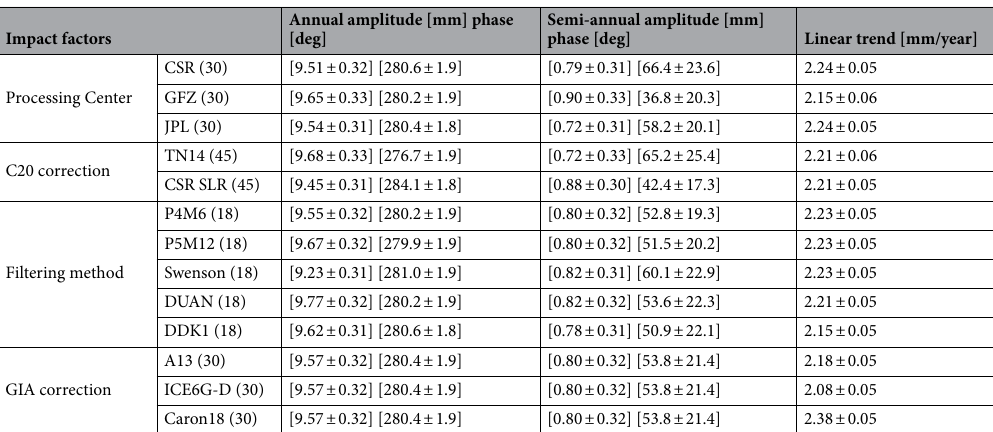
Table 4. The sub-ensemble mean amplitudes of annual and semiannual components and linear trends of global mean barystatic sea-level changes from GRACE/GRACE-FO solutions over January 2005 to December 2019. The (30), (45) and (18) represent the corresponding ensemble solutions. The uncertainty of each single impact factor ensemble (1 sigma for amplitudes, phases and